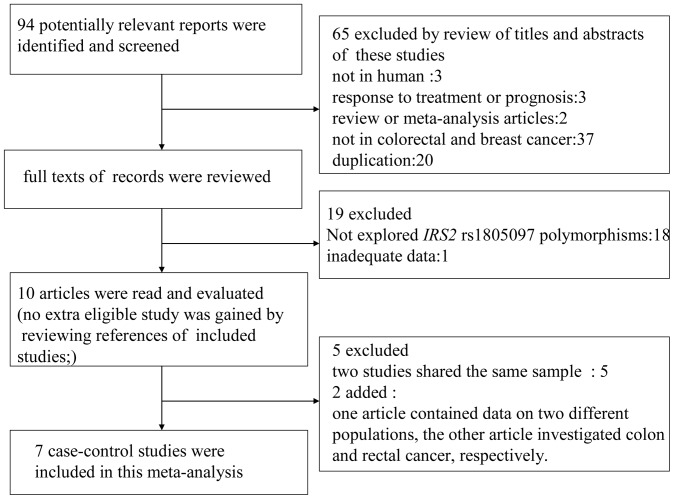
Flow diagram of the study selection process.